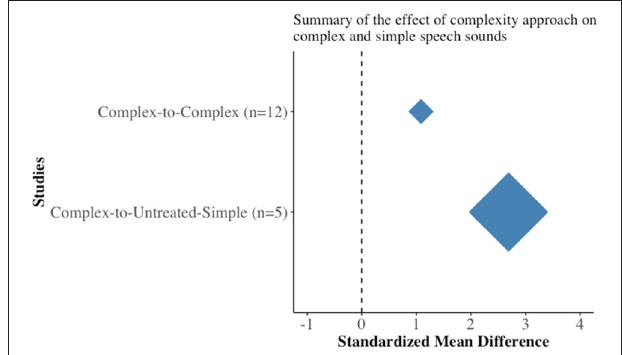
FIGURE 3 | Diamond plot depicting the summary (weighted) effect sizes on the treated complex and untreated simple speech